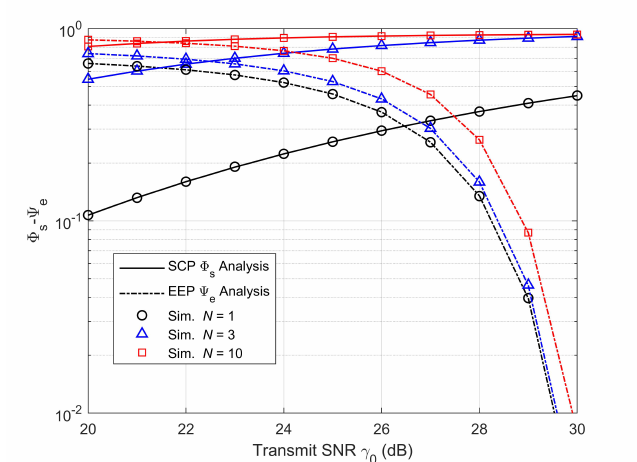
Figure 3. Impacts of average transmit SNR and the number of IRS